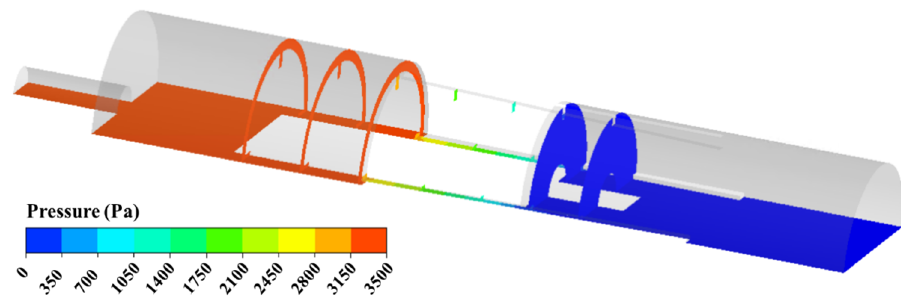
Figure 9. Pressure distribution with inlet pressure of 3.5 kPa.